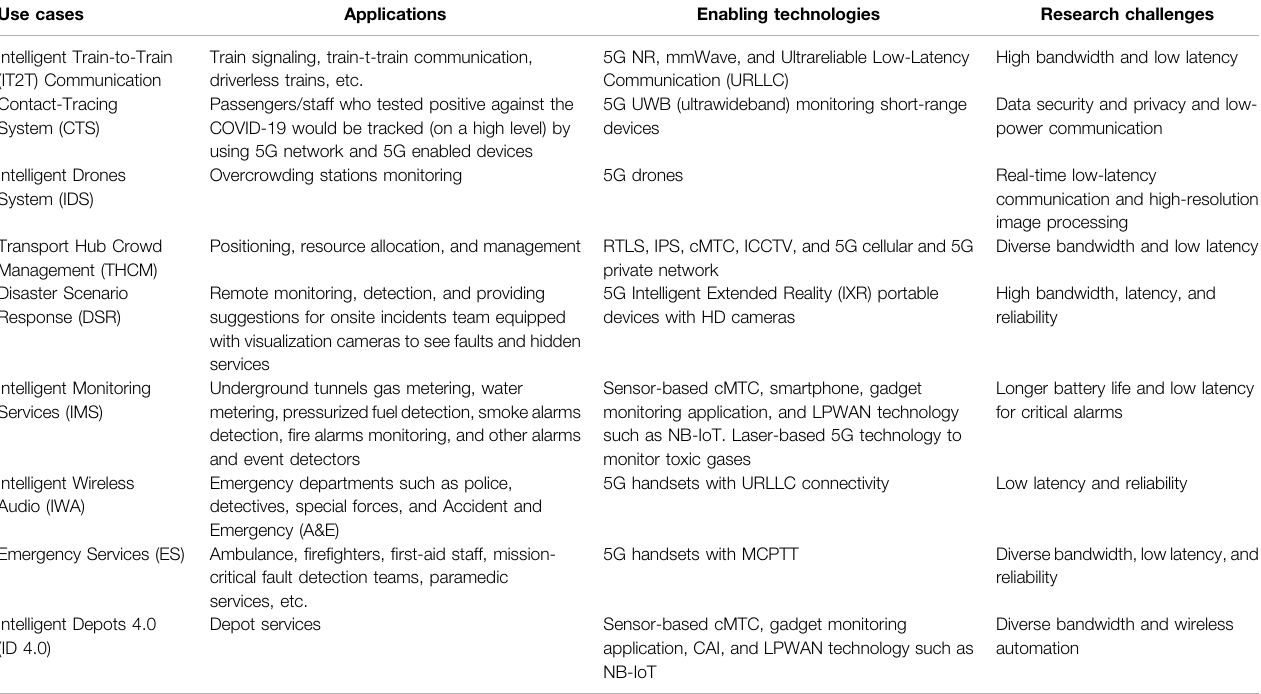
TABLE 1 | Summary of NGRS use cases and